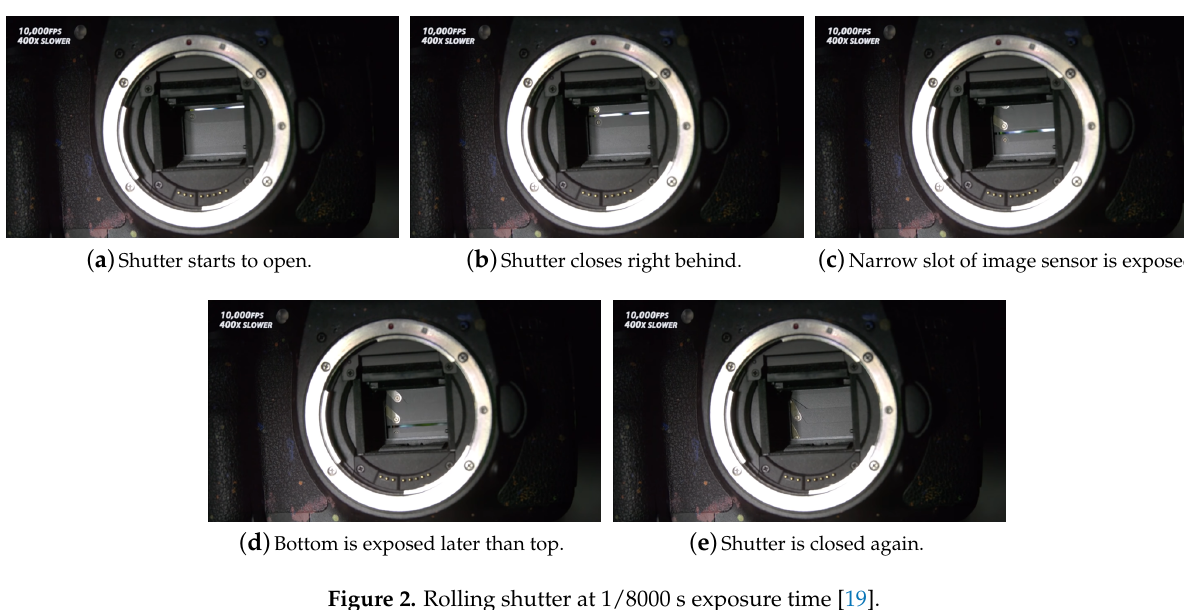
Figure 1. Rolling shutter at 1/30 s exposure time [19].